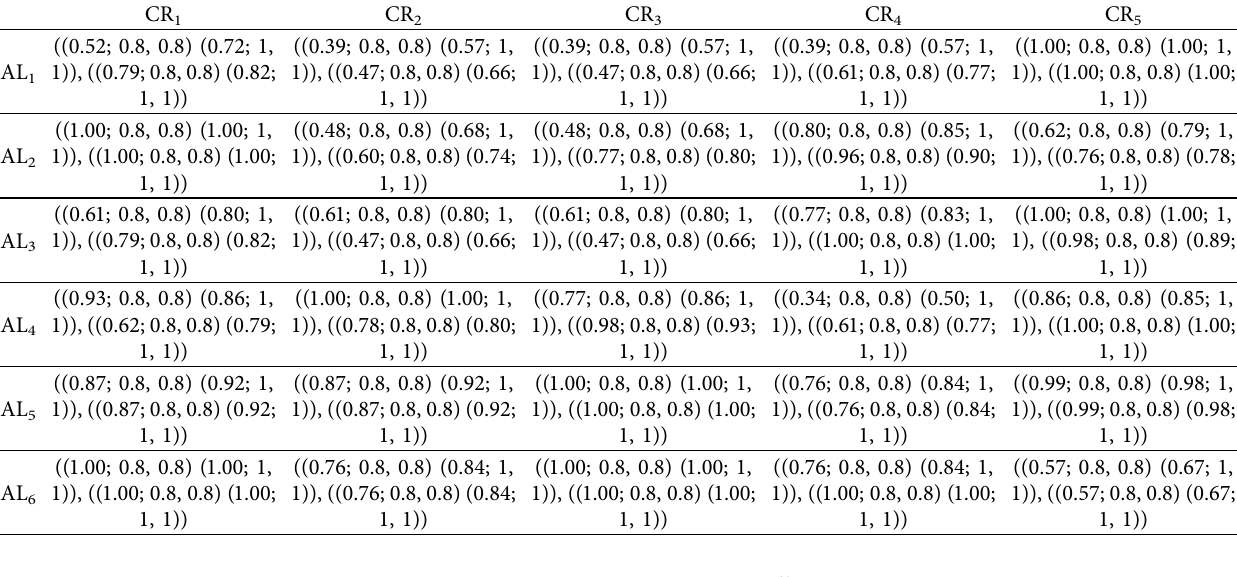
Table 7: Te maximal entropy value.